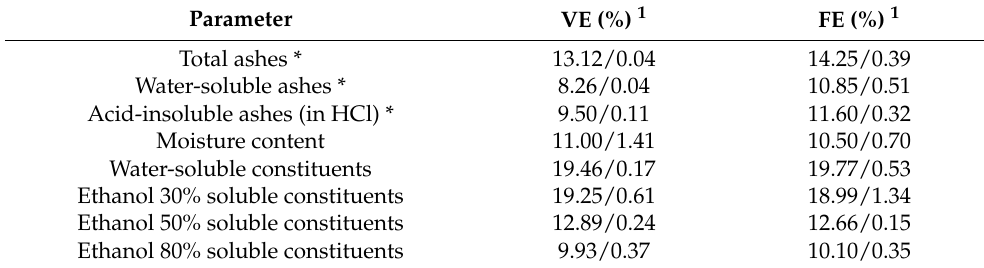
Table 1. Physicochemical parameters of the X. caeruleum leaves collected in vegetative (VE) and flowering (FE) stages.